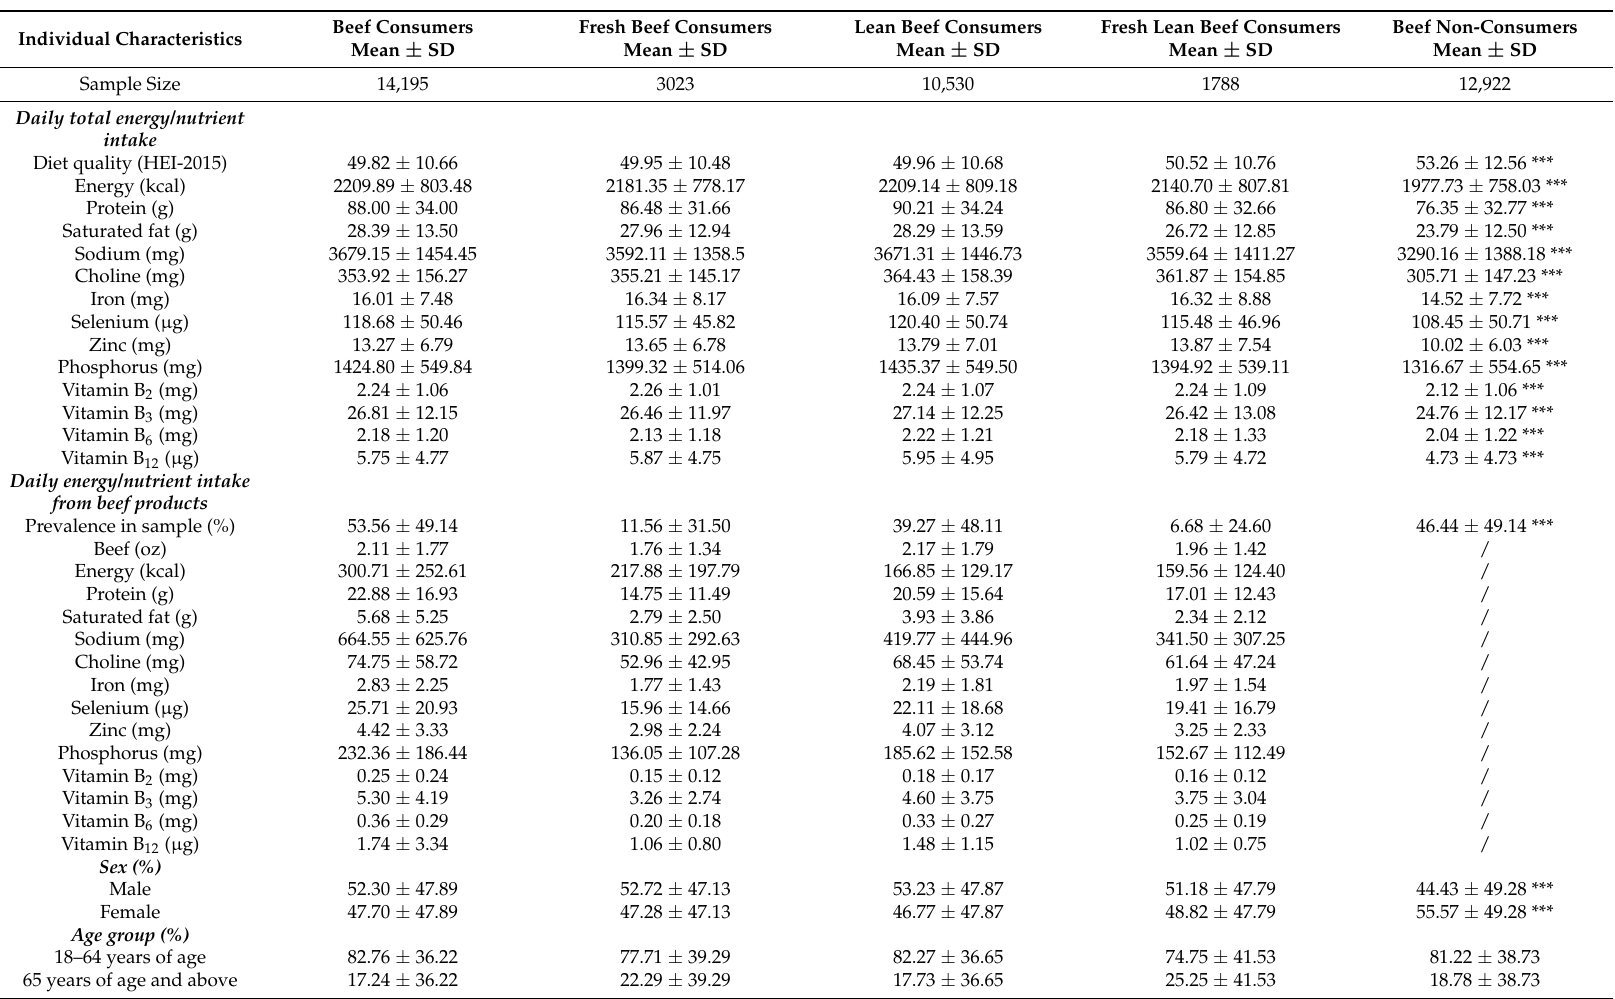
Table 1. Individual characteristics of 2005–2016 NHANES adult beef, fresh beef, lean beef, and fresh lean beef consumers and beef non-consumers. Individual